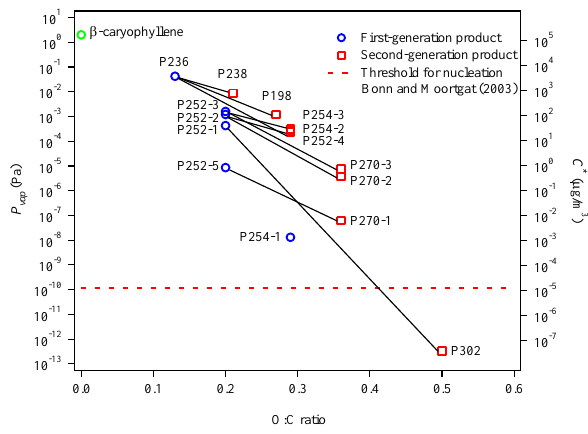
Fig. 5. Estimated saturation vapor pressures P vap and saturation vapor concentrations C ∗ plotted against the O:C elemental ratio of β -caryophyllene and its ozonolysis products. The dashed red line is the threshold saturation vapor pressure at which new particle forma- tion occurs, as suggested by Bonn and Moortgat (2003). Black lines connect first-generation products to their second-generation coun- terparts. Although each first-generation product can be expected to produce multiple possible second-generation products (e.g., such as three products from P236), for clarity of presentation only those products actually observed in the particle phase on the basis of the present study’s results are represented in the figure.